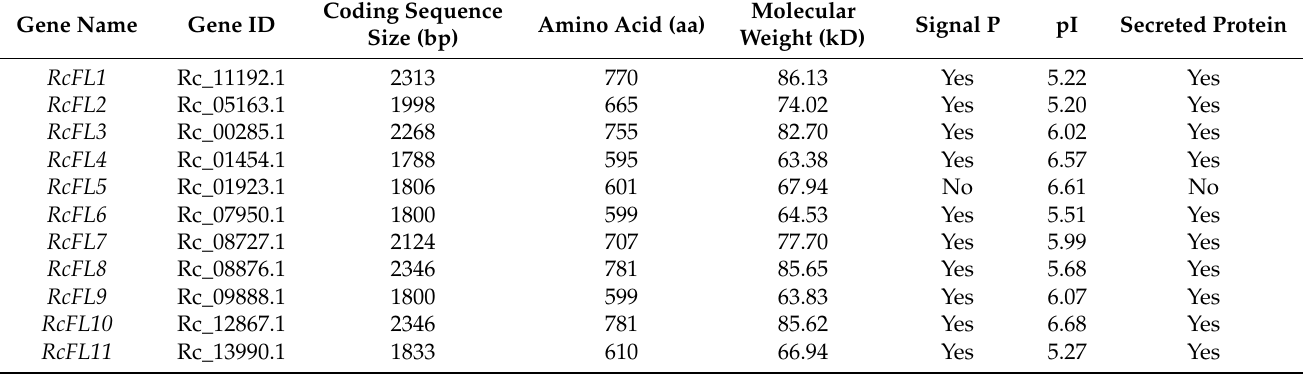
Table 1. Characteristics of 11 MEP36 metalloprotease genes ( RcFLs ) in R. cerealis.